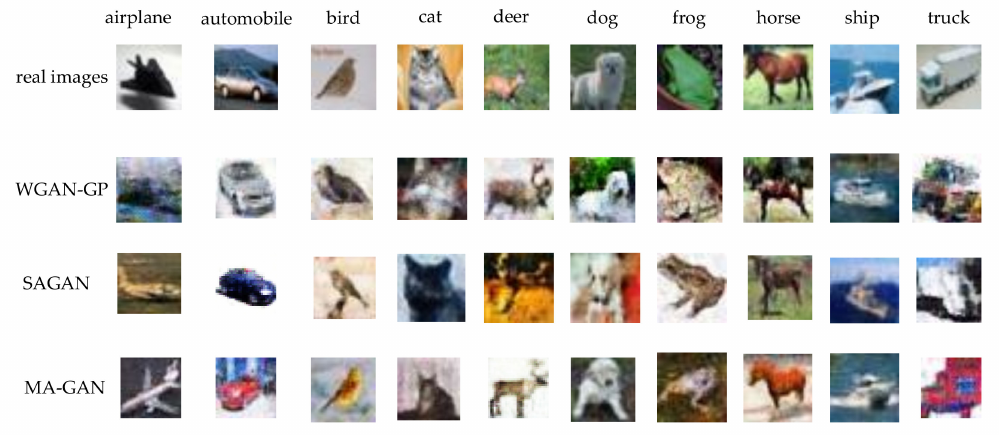
Figure 10. Comparison of CIFAR-10 generated by different